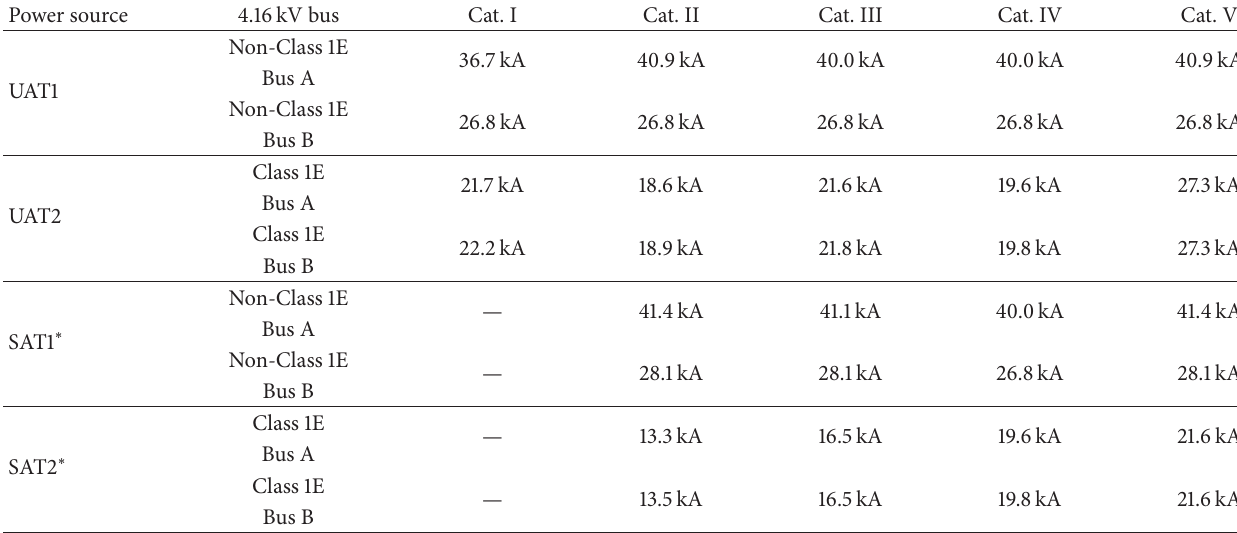
Table 7: The result of the modified electric power system short circuit current